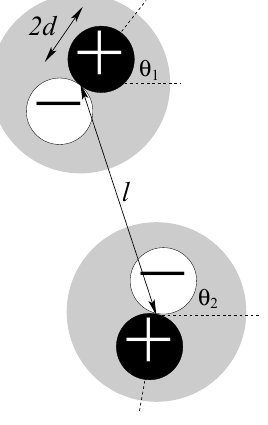
Fig. 5 – Schematic representation of two electric dipoles, i.e. dimers composed of positively and negatively charged colloids, in the traps (shaded circles). Here 2 d is the size of a colloid whereas the other parameters have the same meaning as in Figure